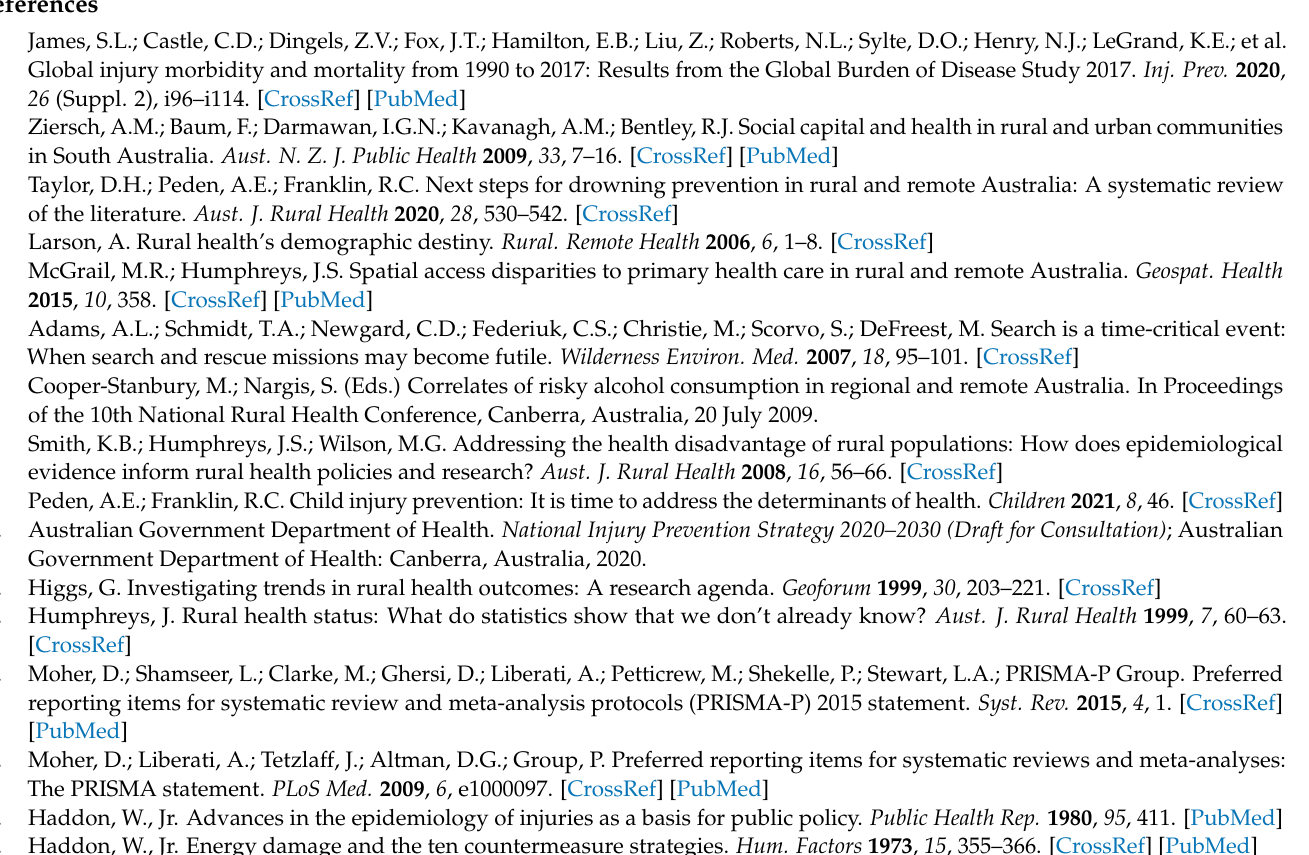
Table S4: Injury Epidemiology by rural in Australia; Table S5: Risk factors for rural injury; Table S6: Increase Morbidity/Mortality of injury risk